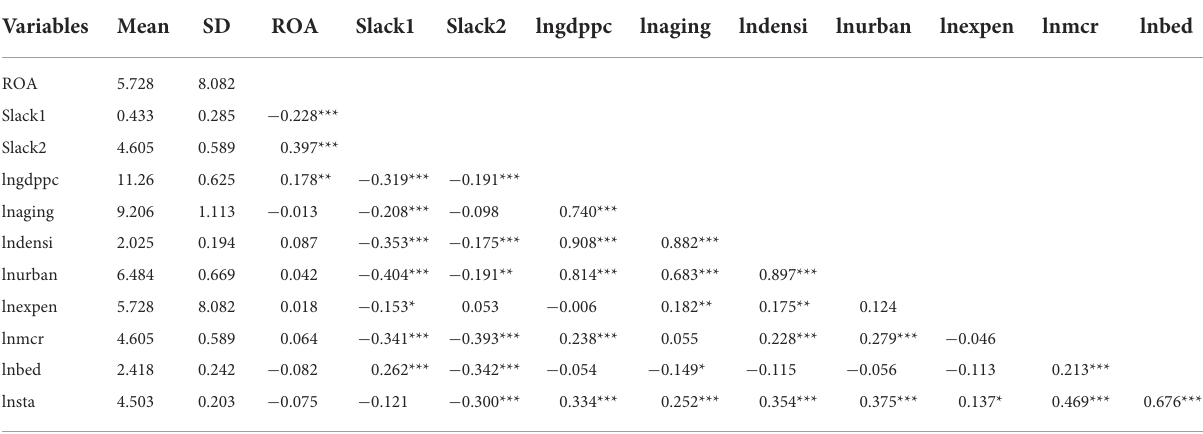
TABLE 1 Correlation analysis of